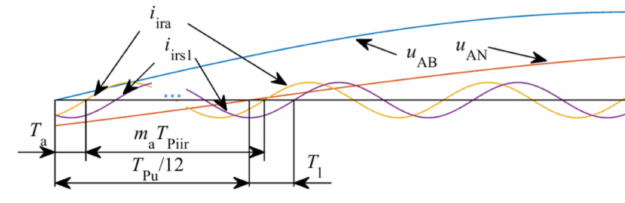
Figure 8. Relationship between T a and T